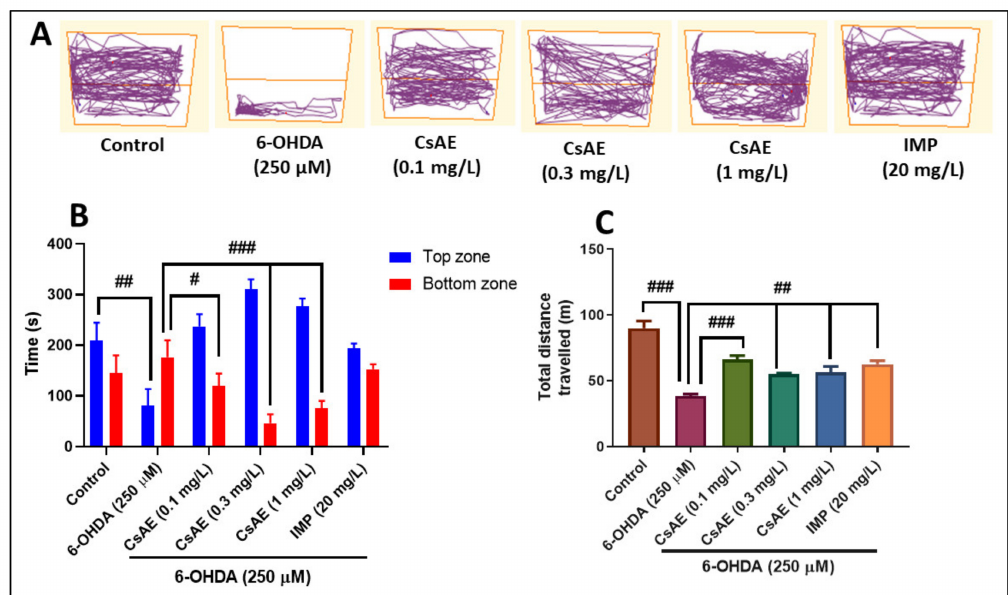
Figure 4. Ceratonia siliqua aqueous extract (CsAE, 0.1, 0.3, and 1 mg / L) ameliorated locomotion pattern and reduced anxiety in the NTT test. ( A ) Representative locomotion tracking pattern of the control, 6-hydroxydopamine (6-OHDA) (250 µ M), CsAE (0.1, 0.3, and 1 mg / L), and imipramine (IMP) (20 mg / L) treated groups. ( B ) Represent the time spent in the top / bottom zone by zebrafish in the tank in di ff erent groups. ( C ) Represent the total distance travelled by zebrafish in the tank in di ff erent groups. Values are means ± S.E.M. ( n = 10). For Tukey’s post hoc analyses: ( B ) Control vs. 6-OHDA (250 µ M): ## p < 0.001, 6-OHDA (250 µ M) vs. CsAE (0.1 mg / L): # p < 0.01, 6-OHDA (250 µ M) vs. CsAE (0.3 mg / L): ### p < 0.0001 and 6-OHDA (250 µ M) vs. CsAE (1 mg / L): ### p < 0.0001; ( C ) Control vs. 6-OHDA (250 µ M): ### p < 0.0001, 6-OHDA (250 µ M) vs. CsAE (0.1 mg / L): ###p < 0.0001, 6-OHDA (250 µ M)